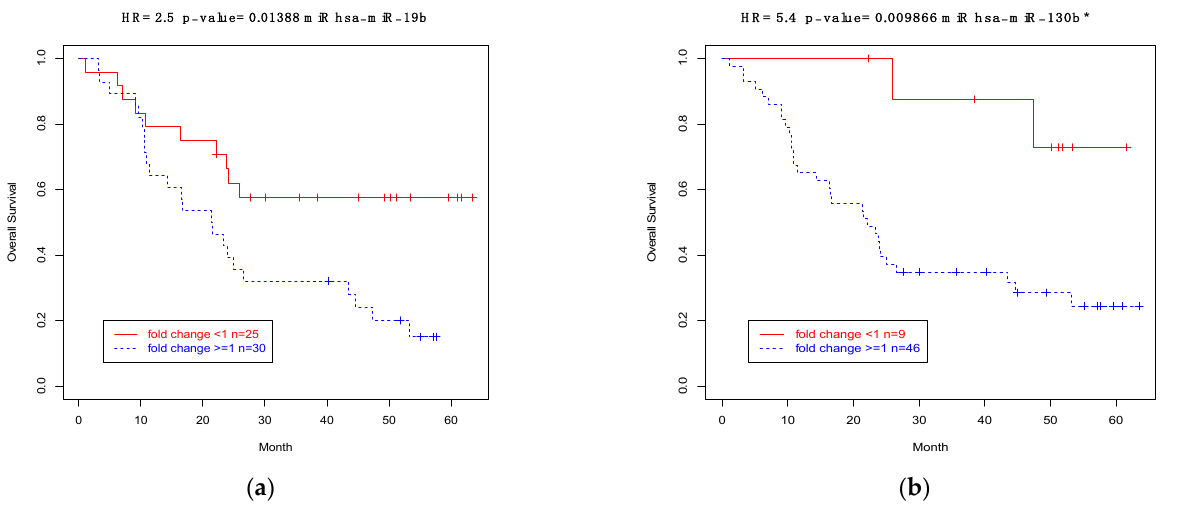
Figure 6. ( a ) ESCC case survival by miR-19b expression (Kaplan–Meier plot, HR from proportional hazards model). ( b ) ESCC case survival by miR-130b* expression (Kaplan–Meier plot, HR from proportional hazards model).